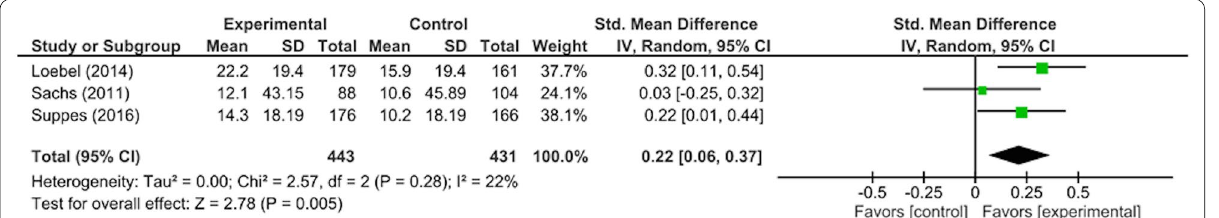
Fig. 5 Forest plot of post-intervention treatment effect sizes for improvement in quality of life. CI, confidence interval; SD, standard deviation; MS, mood stabilizers, including lamotrigine, lithium, and valproate; SGA, second-generation antipsychotics